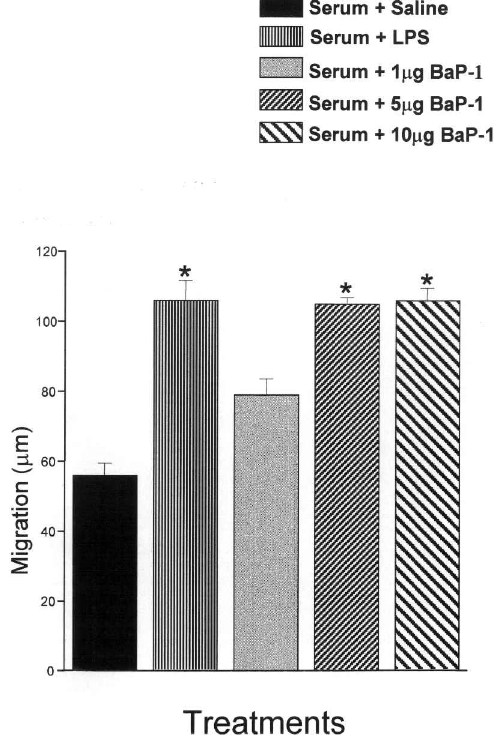
FIG. 4. Chemotactic responses of neutrophils to serum treated with Bothrops asper metalloproteinase BaP–1 or with lipopolysaccharide (LPS). Neutrophils were placed in the top compartment of the chamber and allowed to migrate for 1h. BaP–1 or LPS were incubated with serum for 30min at 37°C, diluted in Hanks’ balanced solution (HBSS) and used as chemotactic agents. Values are mean ± standard error of the mean (SEM) of four experiments each performed in duplicate. * p < 0.01 versus values obtained in the group using non-activated